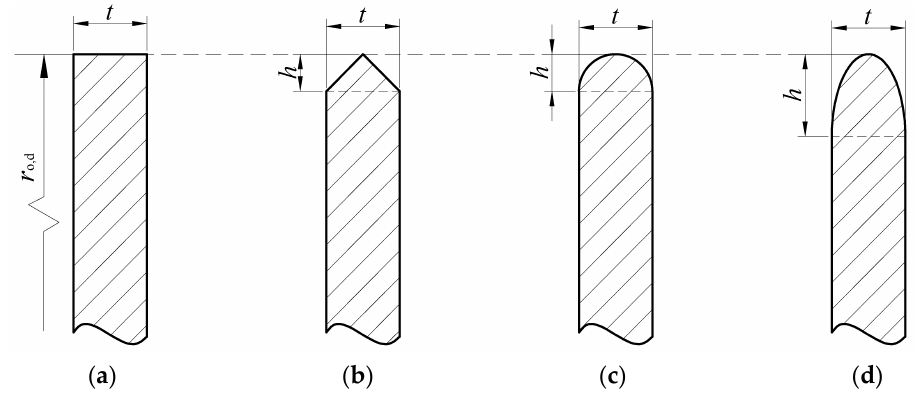
Figure 4. Cross-section map of several kinds of discs with different disc tips. ( a ) Blunt tip; ( b ) triangular tip; ( c ) circular tip; ( d ) elliptic tip. ( b ) triangular tip; ( c ) circular tip; ( d ) elliptic tip.